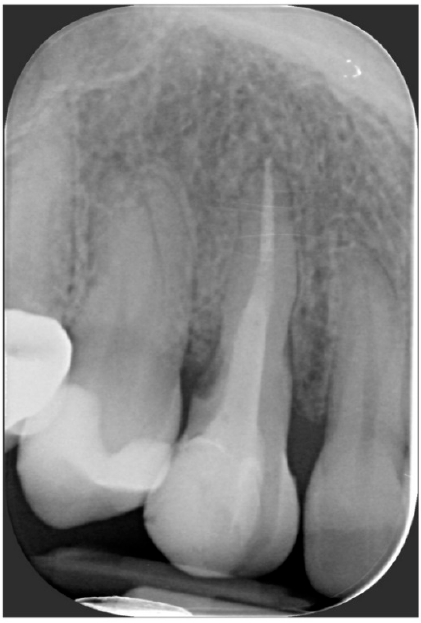
Figure 2. Radiographic evaluation revealing internal root resorption.